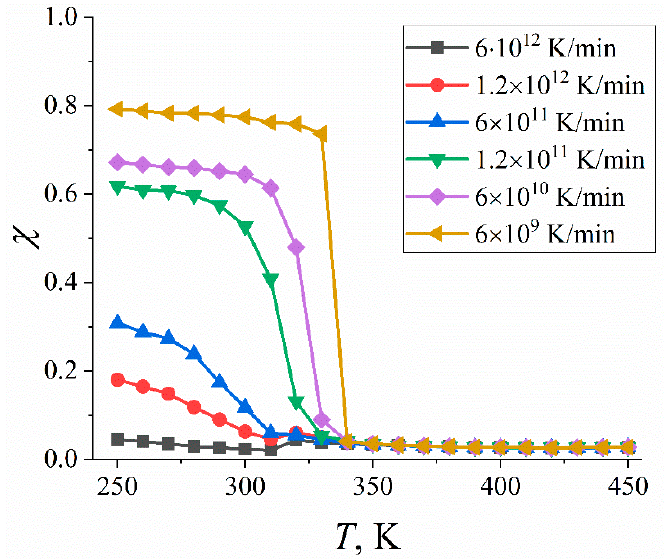
Figure 6. Crystallinity χ of n-eicosane samples as a function of temperature T for different cooling rates. The crystallinity is evaluated with the use of the approach of Yamamoto et al. [36].